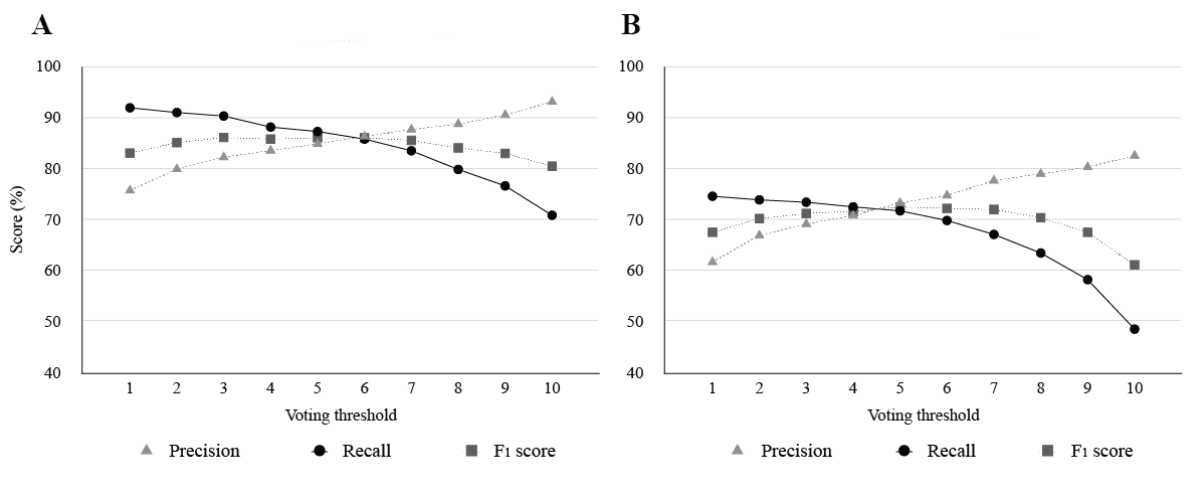
Figure 2. Results of the voting ensemble for (A) subtask 1: entity identification and (B) subtask 2: relation